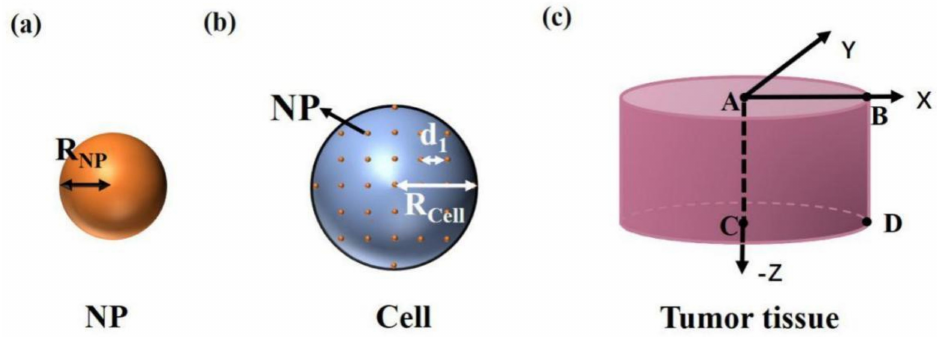
Figure 1. Simplified physical model of ( a ) a nanoparticle, ( b ) a cell, and ( c ) tumor